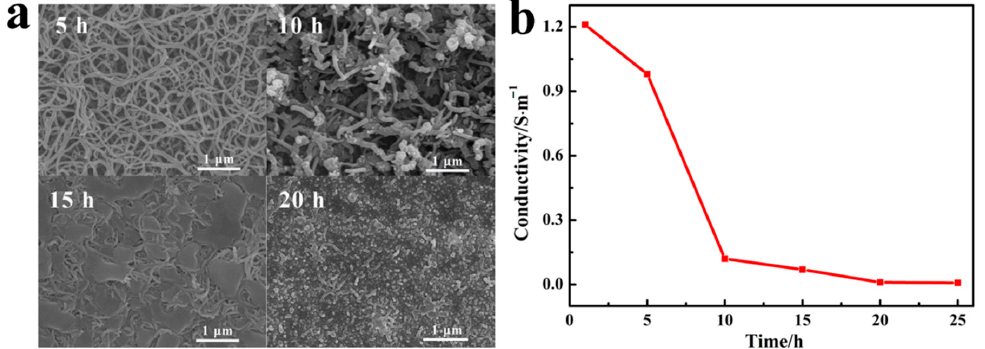
Figure 3. ( a ) SEM images of PPy/PDA NWs with different deposition time of PDA. ( b ) The conductivity of PPy/PDA NWs with different deposition time of PDA.